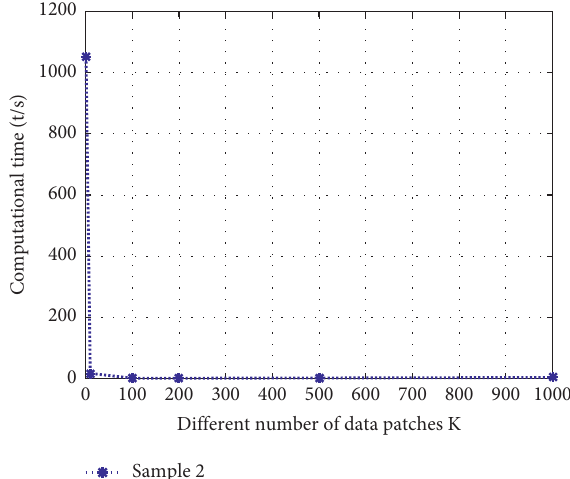
Figure 3: Relationship between computational time and number of data set blocks in scenario (2).